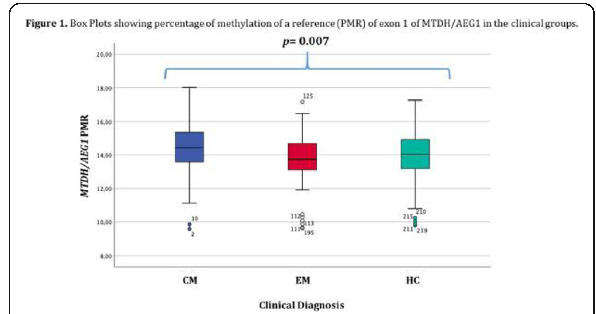
Fig. 1 (abstract P030). See text for description